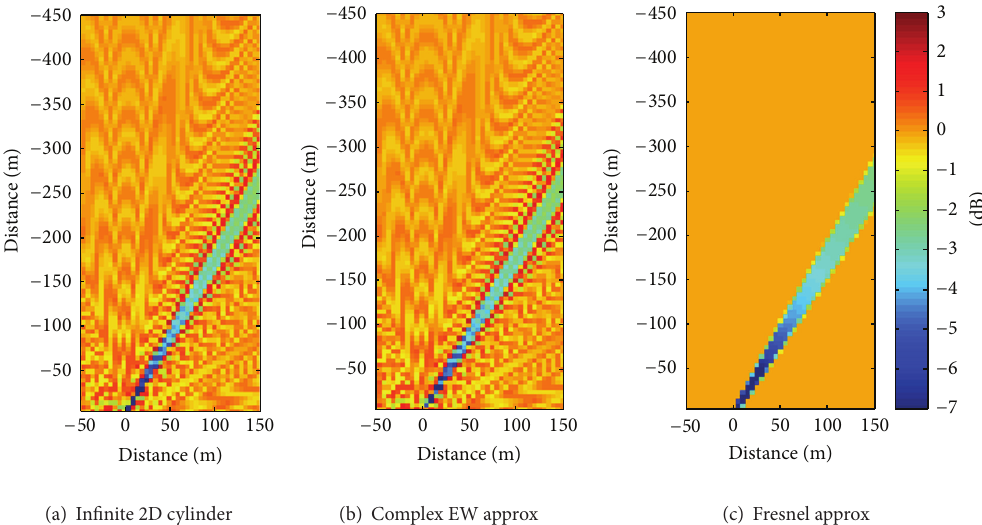
Figure 7: Computed near-field distribution around an infinite 2D cylinder at 500 MHz. (a) Exact numerical integration. (b) Complex echo width (EW) approximation. (c) Fresnel